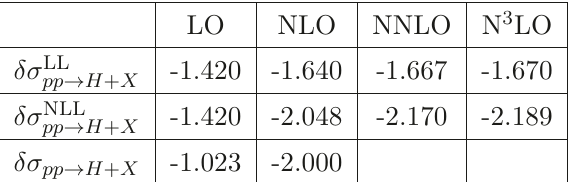
Table 1 . The bottom quark loop corrections in picobarns to the Higgs boson production cross section of different orders in α s given in the leading logarithmic approximation (LL), the next- to-leading logarithmic approximation (NLL) and with full dependence on m b . All the results are obtained with the threshold partonic cross section at center of mass energy of 13 TeV and renor- malization/factorization scales set equal to half the Higgs boson mass. Following the conventions of ref. [6], we use the values of the top and bottom quark Yukawa couplings in the MS-scheme. Our input values at µ = m H / 2 are m b ( µ ) = 2 . 961 GeV and α s ( m H / 2) = 0 . 1252. The top quark mass is set to a very large